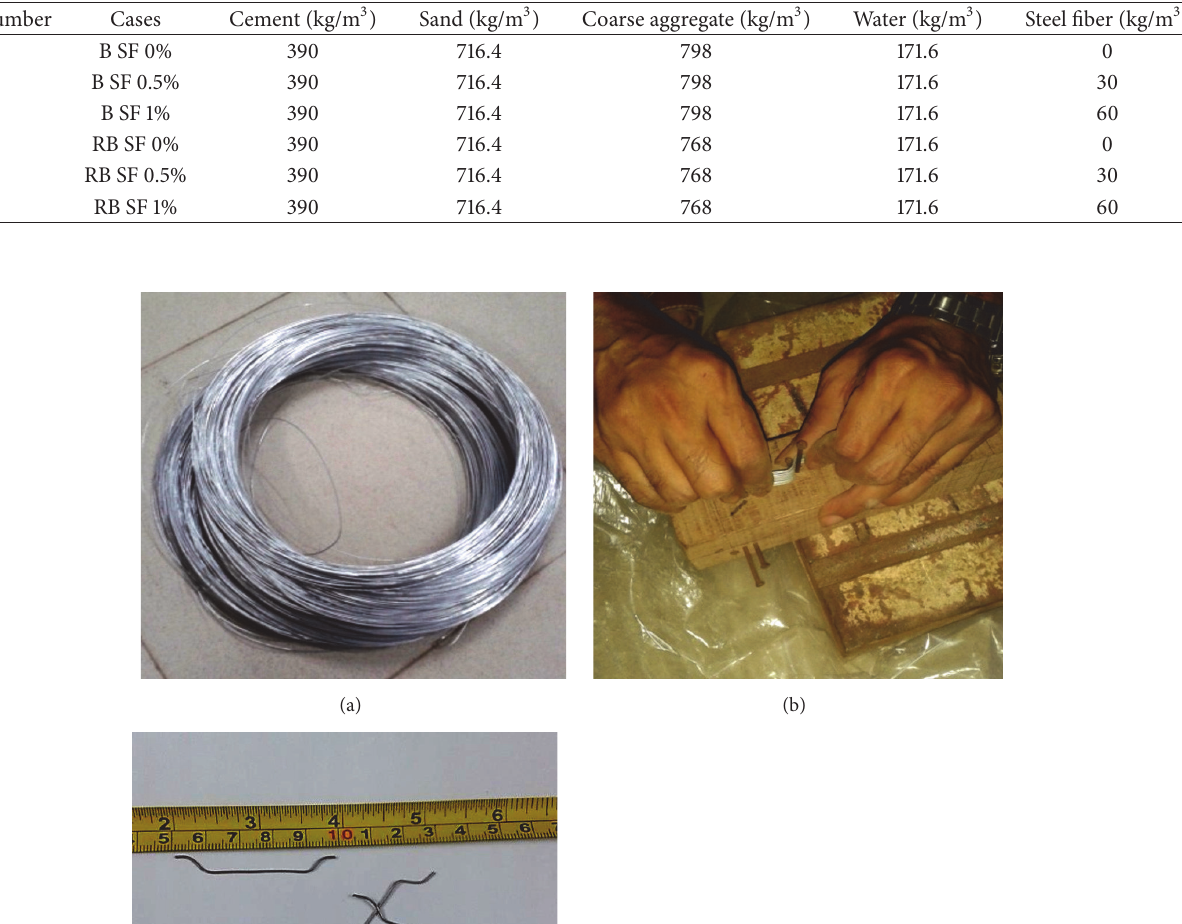
Table 4: Details of concrete mixes considered in the present study.